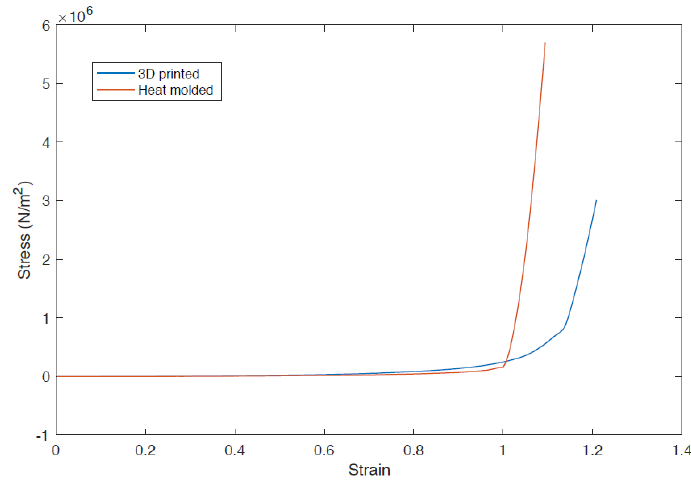
Figure 16. Stress vs strain plot of 3D Printed (blue line) vs heat molded silicone meniscus (red line).